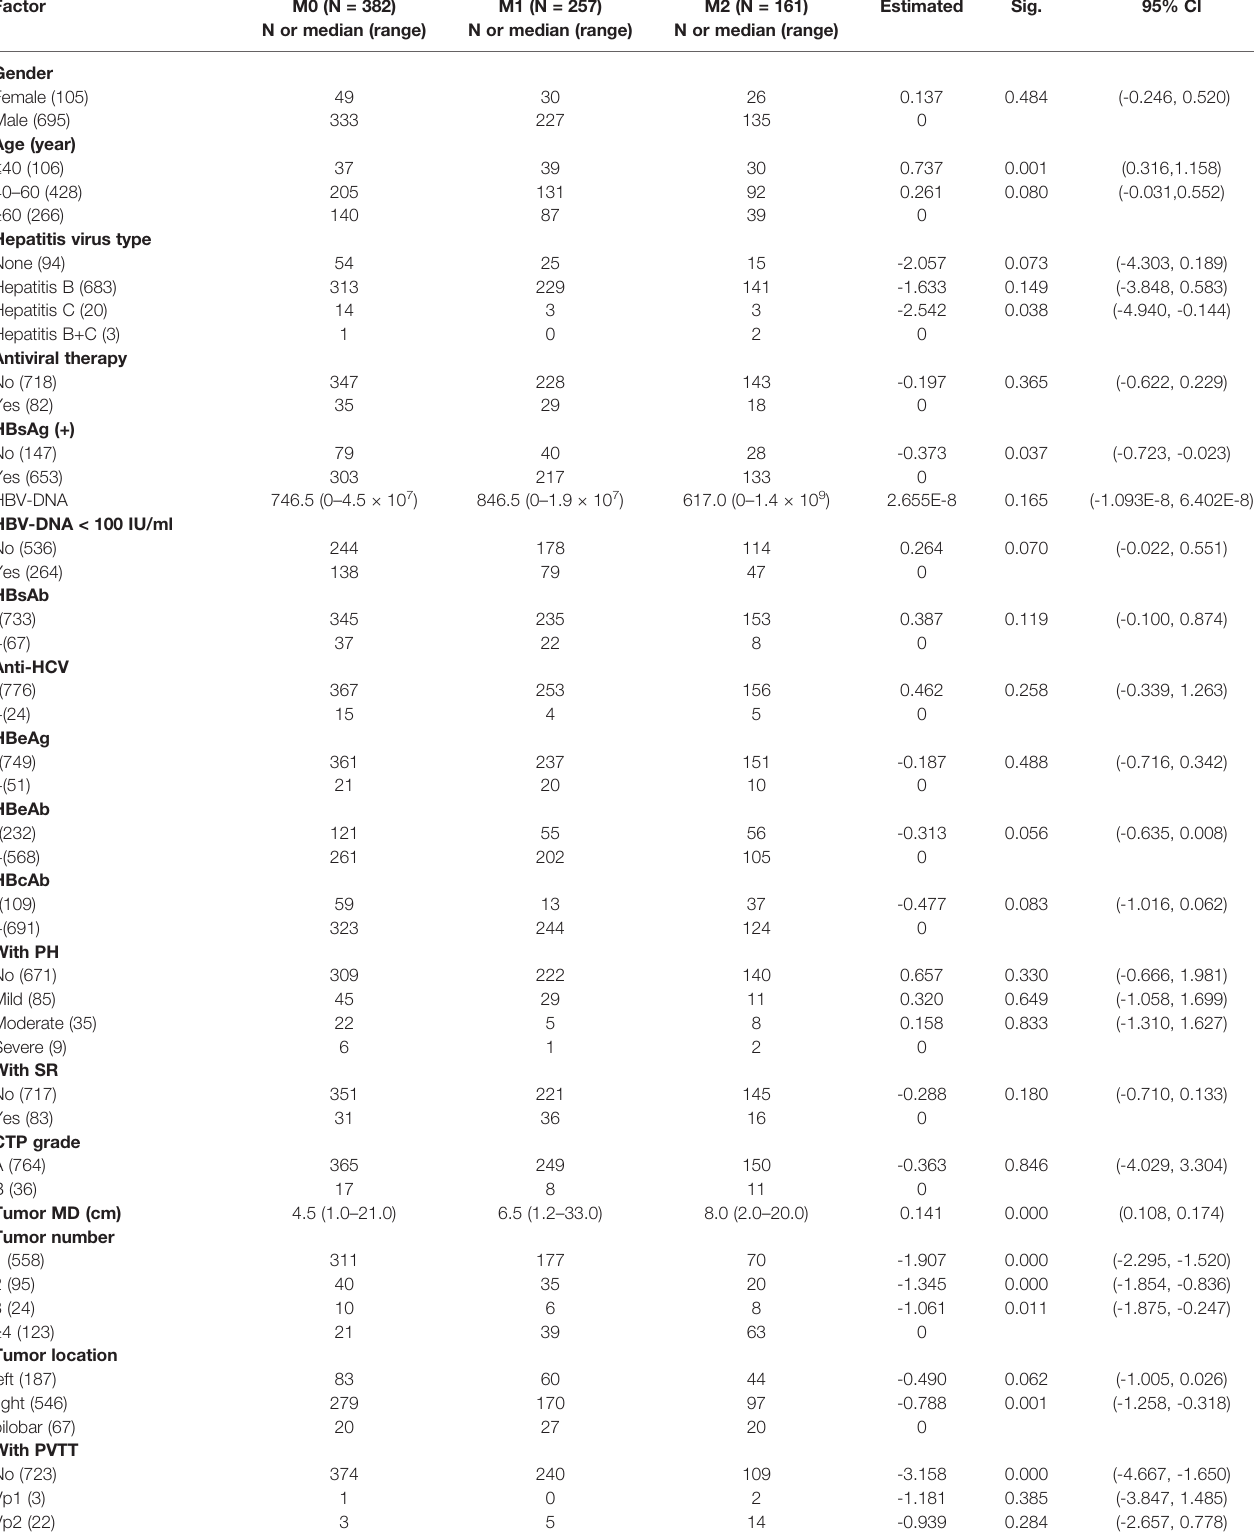
TABLE 3 | Univariate ordinal logistic analysis for MVI presence in the derivation cohort (N = 800).